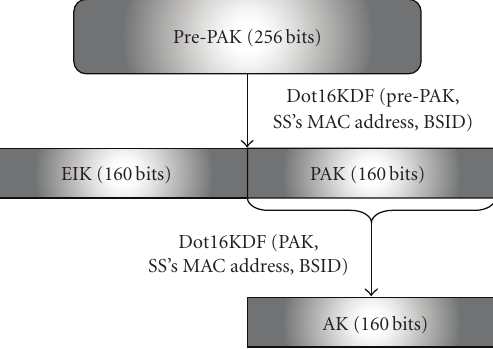
Figure 13: AK derivation with RSA